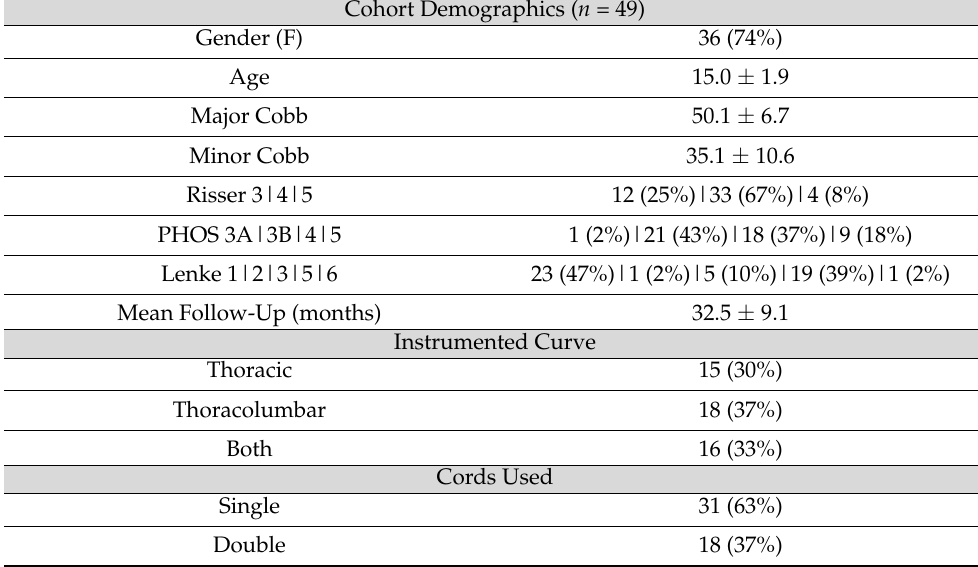
Table 1. Demographics of